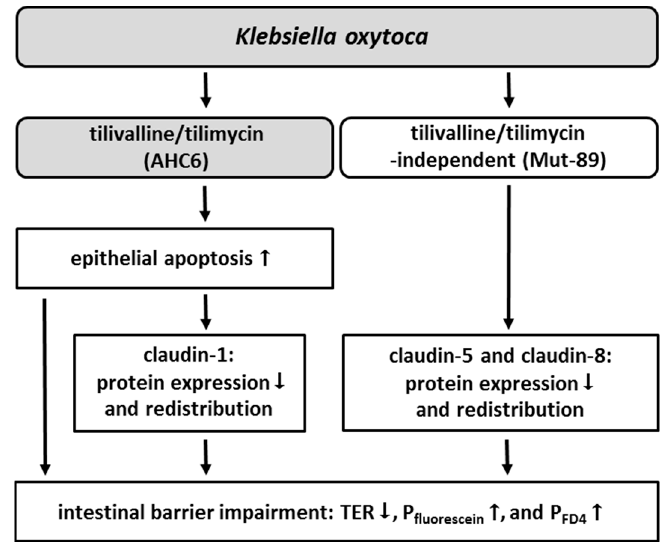
Figure 5. Overview of tilivalline/tilimycin-dependent and -independent effects in K. oxytoca -induced barrier impairment. K. oxytoca causes barrier impairment via two different pathomechanisms. On the one hand, the cytotoxins tilivalline and tilimycin (AHC6) enhance epithelial apoptosis, which is additionally linked to a reduction and redistribution of the tight junction protein claudin-1. On the other hand, the sealing claudins 5 and 8 are reduced and redistributed independently from tilivalline/tilimycin (Mut-89). In consequence, barrier function is impaired, indicated by reduced TER and increased permeability to fluorescein (322 Da) and FD4 (4 kDa).